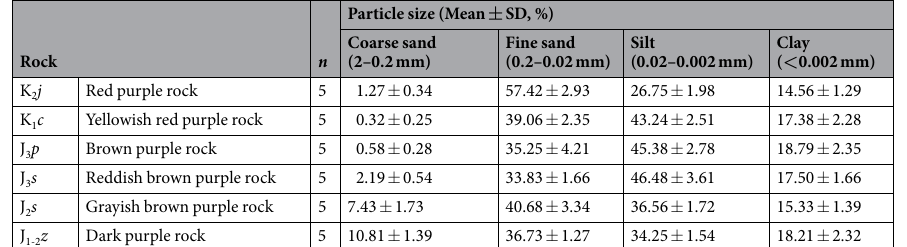
Table 1. The particle size distribution of the purple